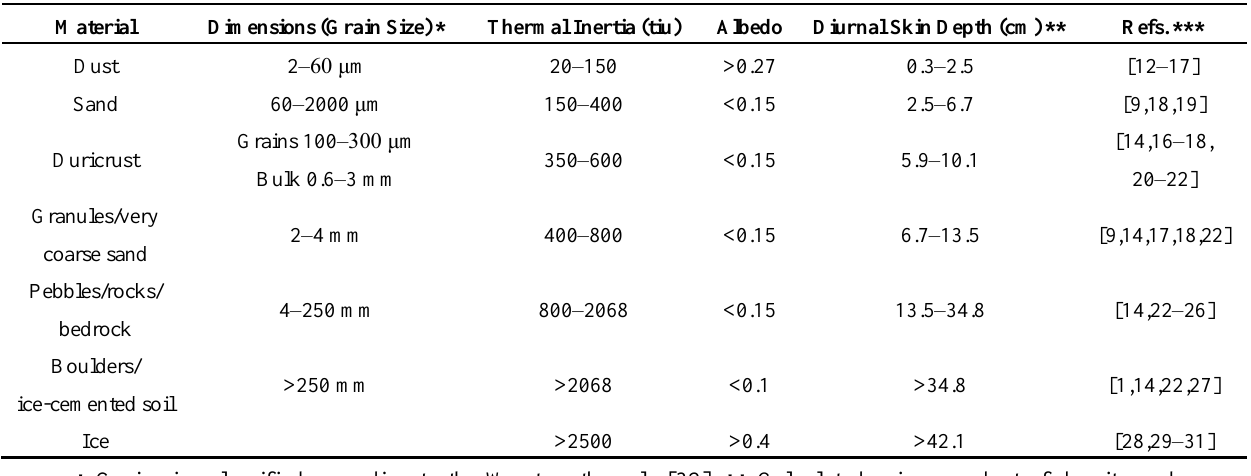
Table 1. Characteristics of primary Martian surface materials, reproduced from